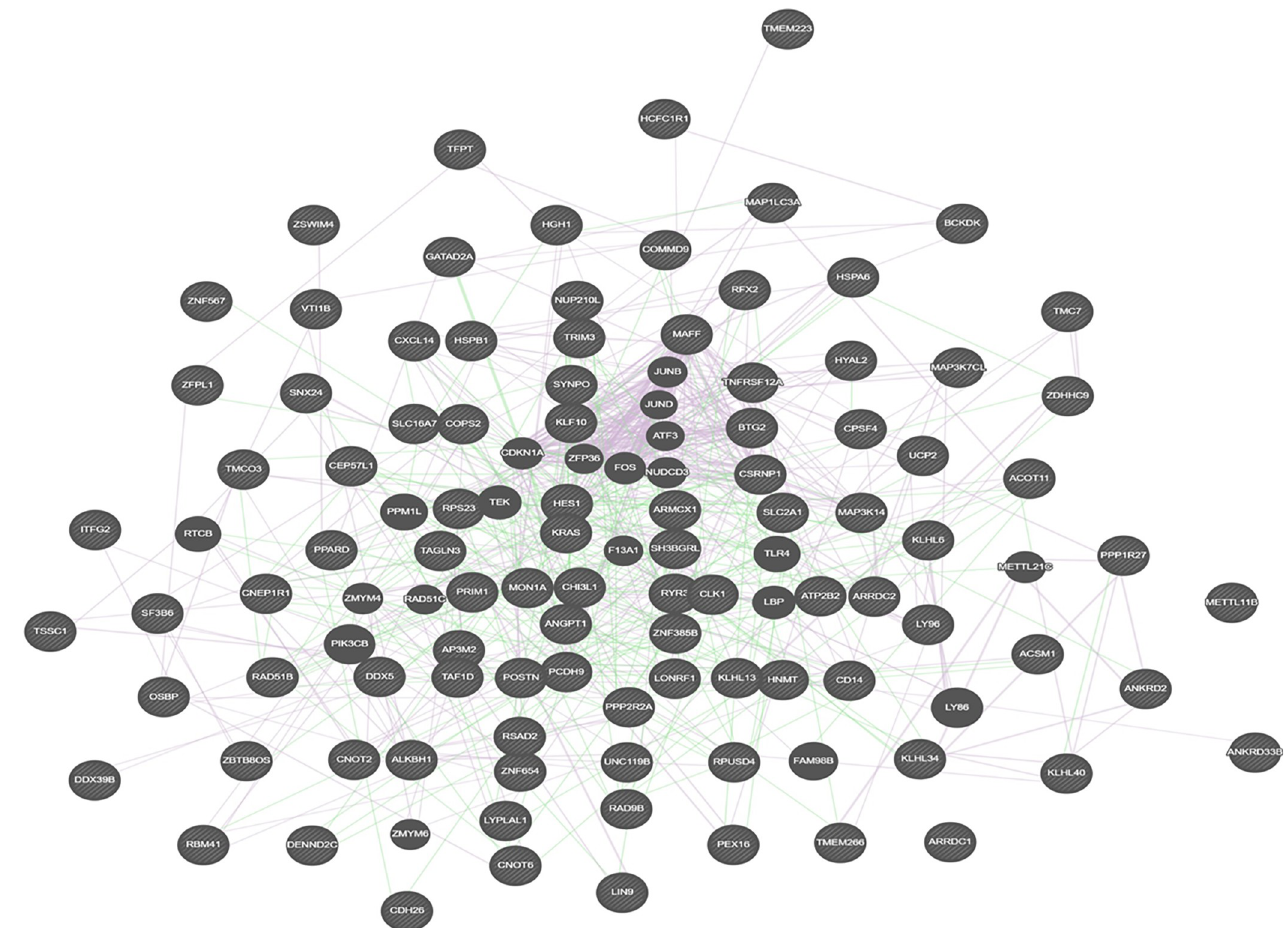
Fig 3. The co-expression network of 99 DE genes based on